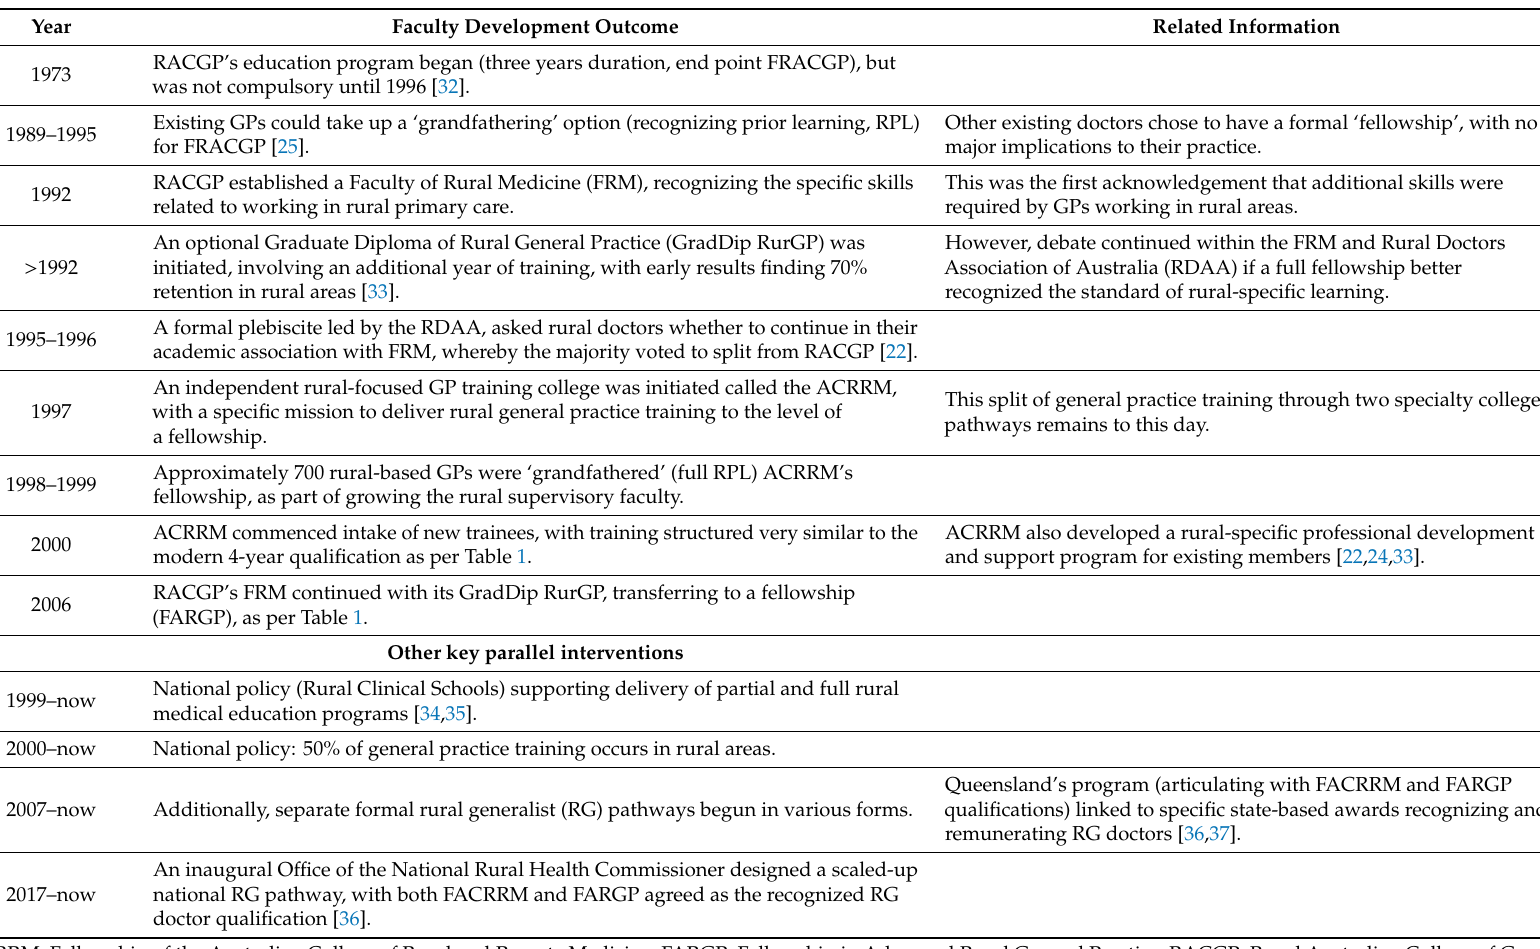
Table 2. Timeline of the development of Australia’s two rural general practice faculties (the Fellowship in Advanced Rural General Practice (FARGP) and the Fellowship of the Australian College of Rural and Remote Medicine